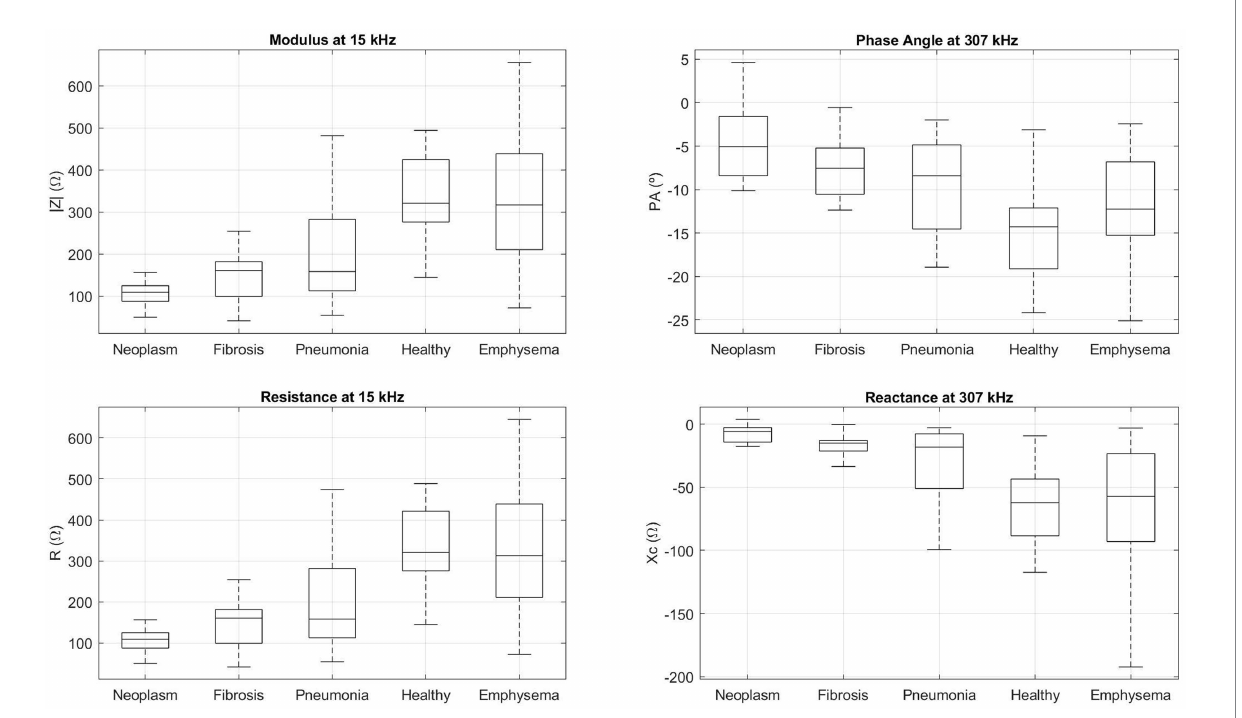
FIGURE 1 Boxplot of the bioimpedance parameters (|Z| and R at 15 kHz and PA and Xc at 307 kHz) for neoplasm, fibrosis, pneumonia, healthy lung tissue and emphysema tissue samples. The central line of each box represents the median of each group, low and upper box lines represent the 25 and 75 percentiles, respectively, and dashed lines belong to the most extreme points which are not considered outliers.